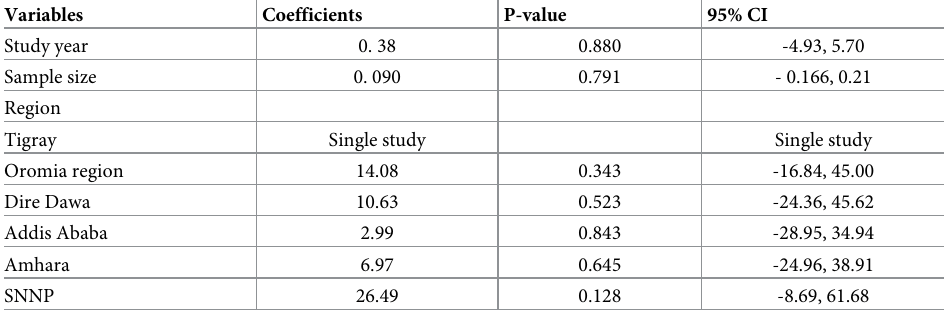
Table 3. Meta-regression output to explore heterogeneity of the pooled proportion of dietary adherence among type 3 diabetes population in Ethiopia from 2012–2020.